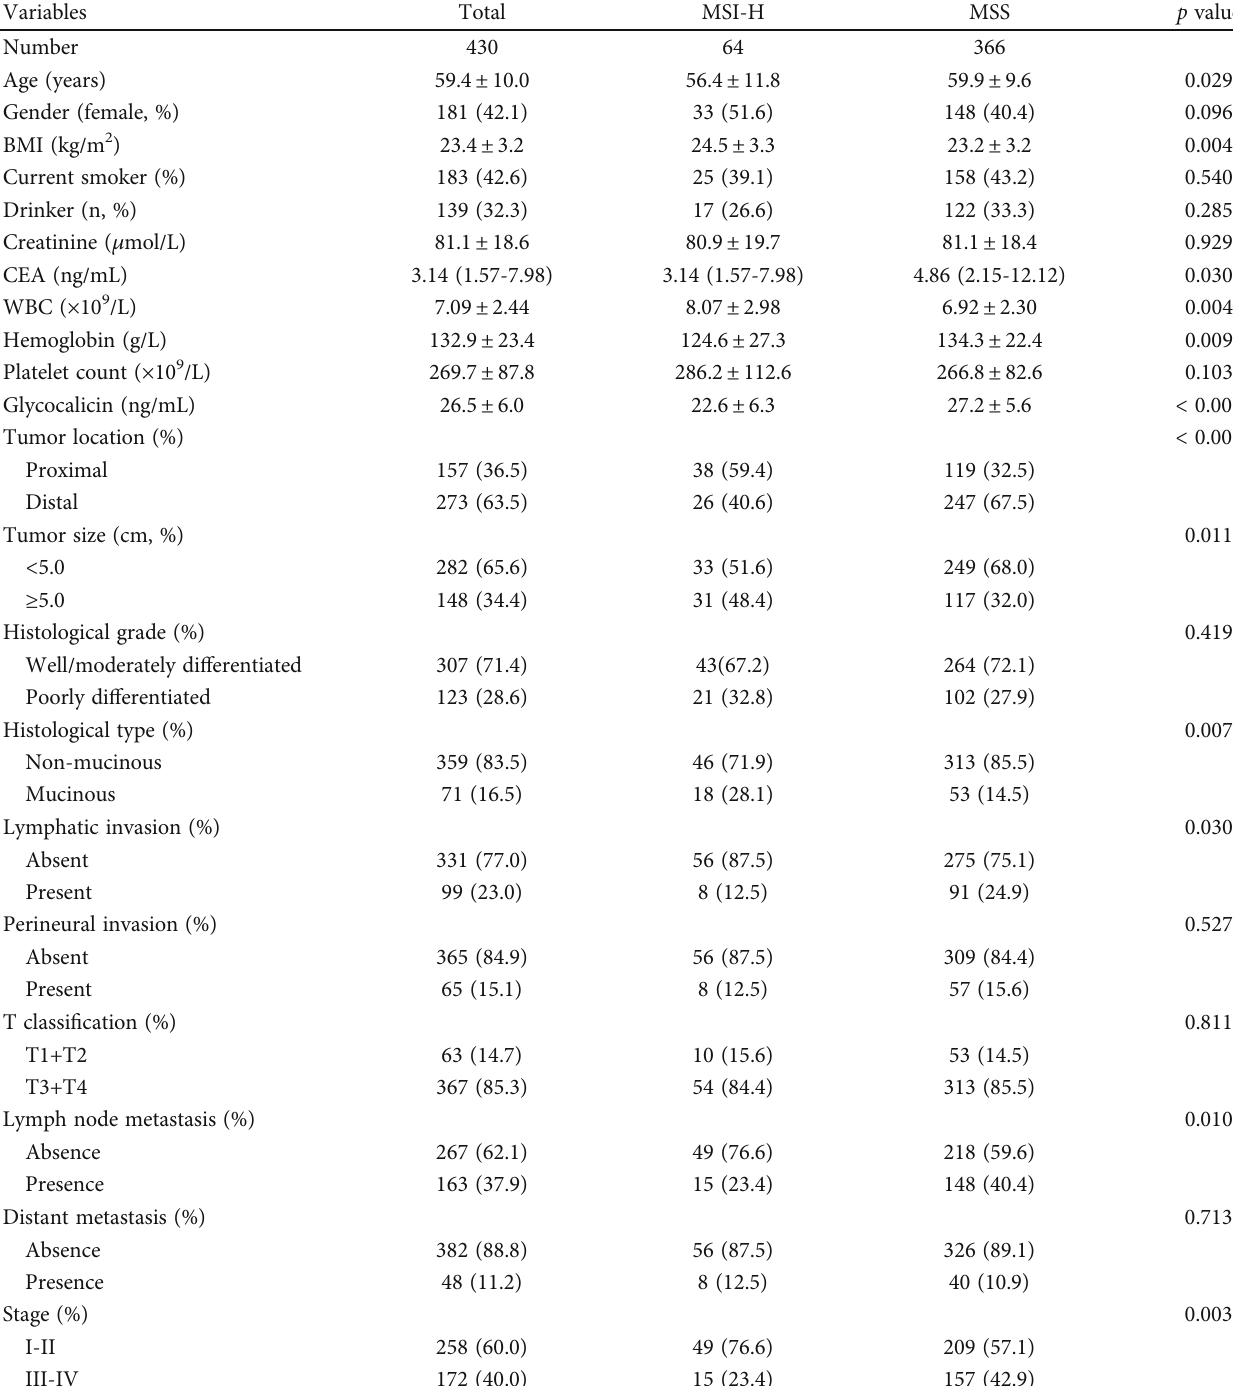
Table 2: Clinicopathological characteristics of the CRC patients according to microsatellite instability